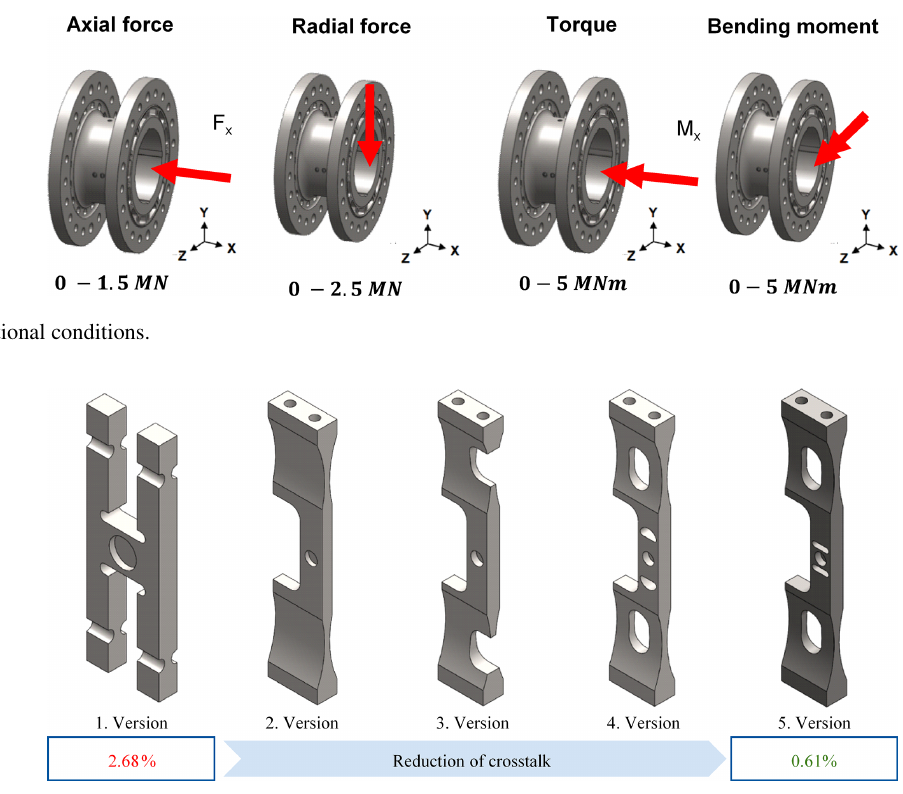
Figure 10. Reduction of crosstalk via an iteration process (loop back): Version 1 shows the initial design (2.68%), Version 2 displays the demand to bring both lateral force elements closer to the middle plane of the MCT (5.46%), Version 3 shows the inclusion of additional flexure hinges (2.2%), and versions 4 and 5 show the optimization of the flexure hinges and profile (1.58% and 0.61%),